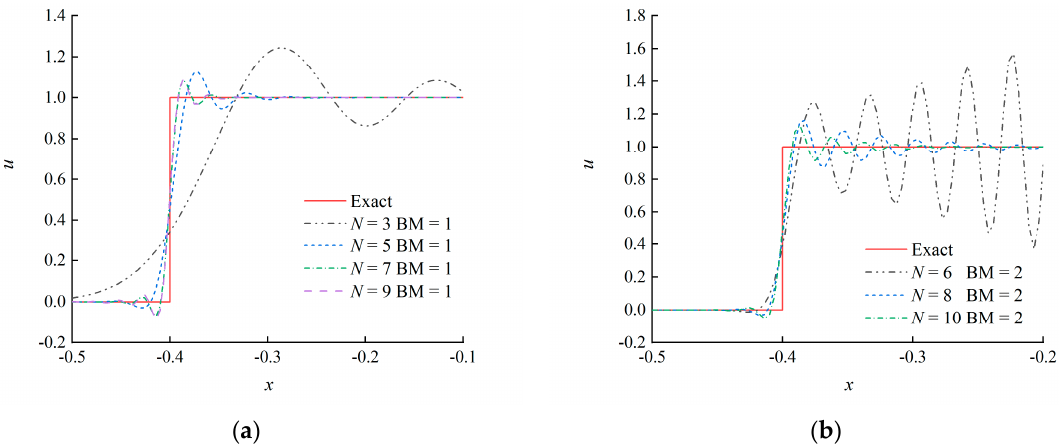
Figure 3. Advection of a square wave by the different schemes at t = 8, J = 8: ( a ) N ∈ odd; ( b ) N ∈ even.